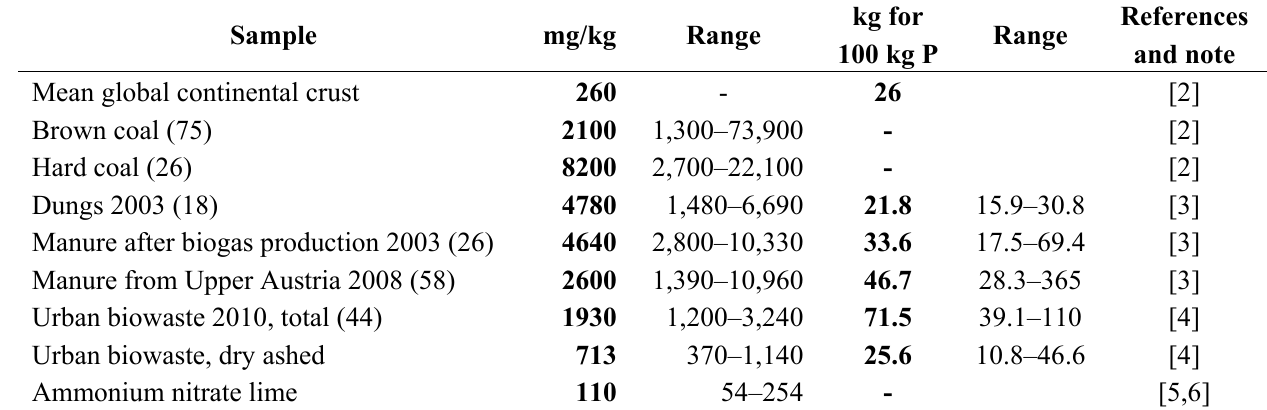
Table 1. Occurrence of sulfur in wastes and coals (in dry mass; number of samples in